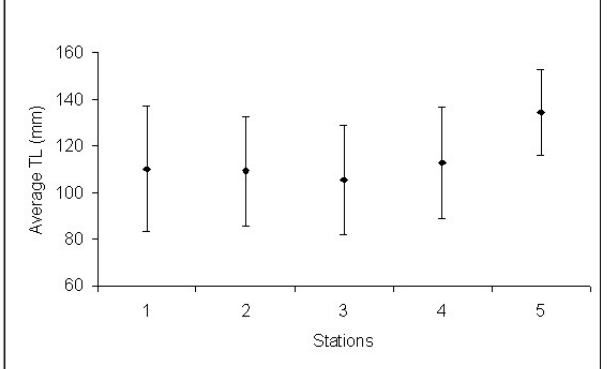
Fig. 3 . Spatial variation of the average length of Citharichthys spilopterus in the Mamanguá Inlet. Bars= standard devia-